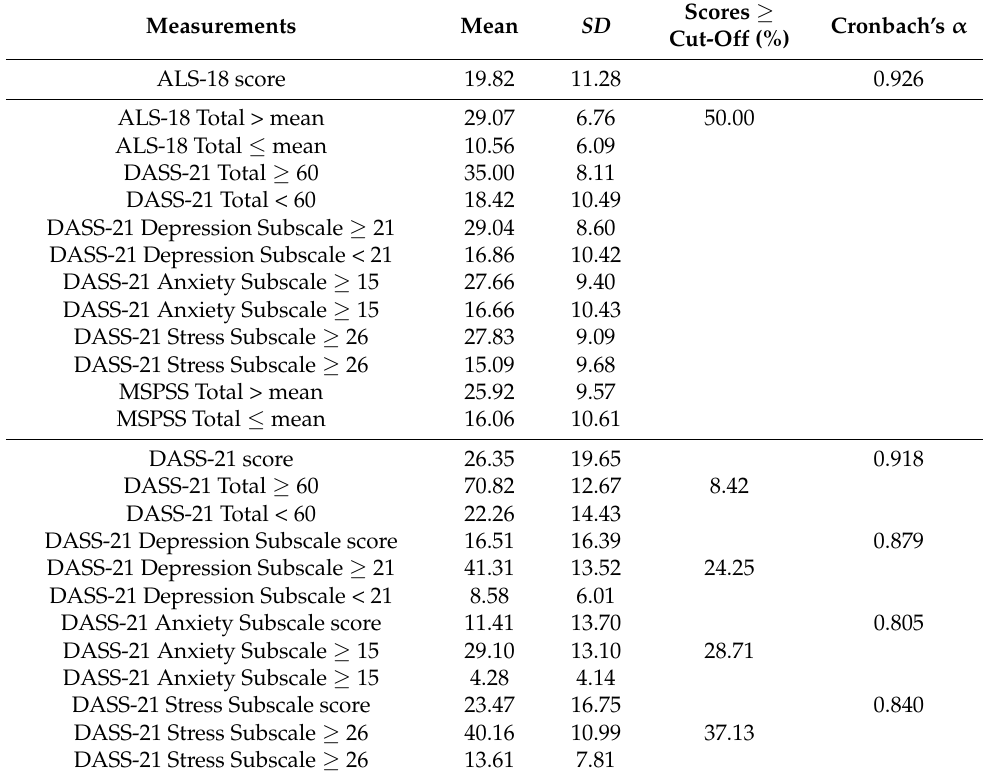
Table 2. Mean scores of ALS-18, DASS-21 (total and subscales), MSPSS (total and subscales), and results of Cronbach’s α in all participating women ( n =